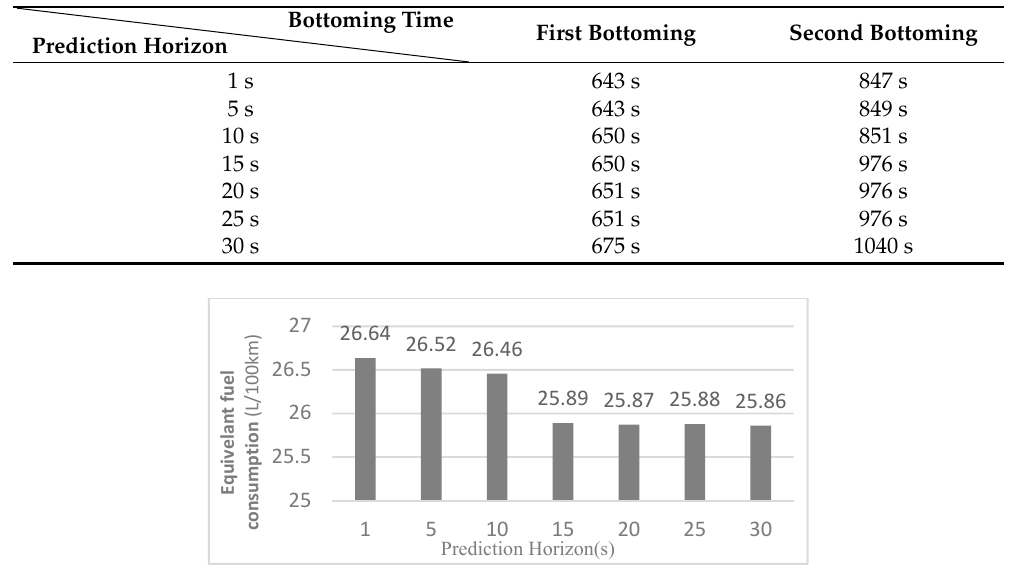
Figure 15. Equivalent fuel consumption under different prediction horizons.